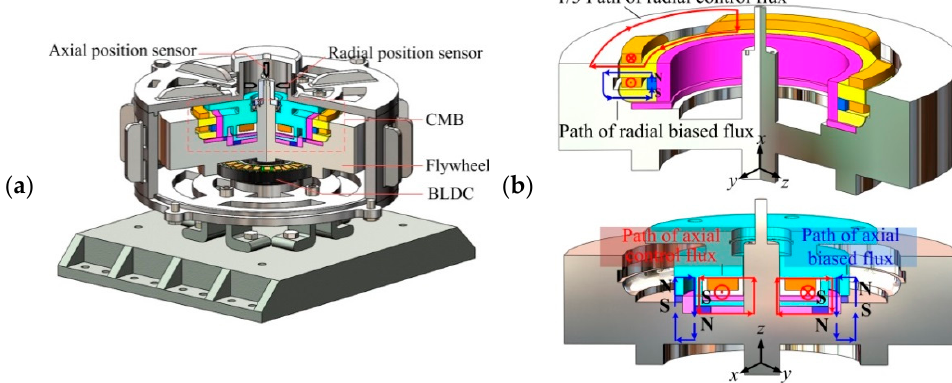
Figure 1. Configuration and magnetic circuit analysis. ( a ) Section view of the prototype. ( b ) Mag- netic bearing of